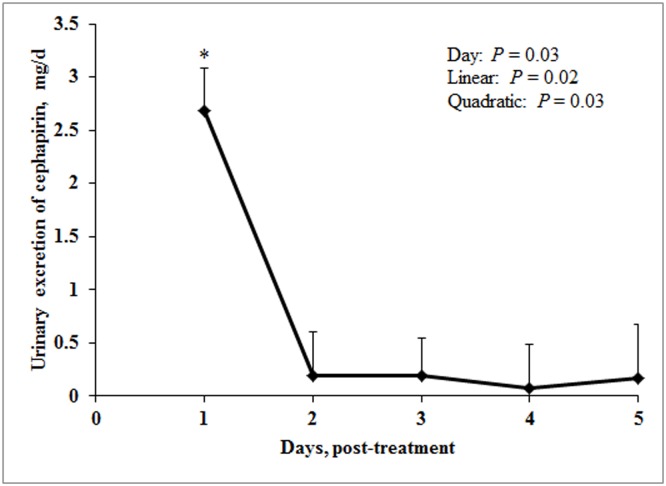
Daily urinary excretion of cephapirin (mg) in dairy cows administered with cephapirin (300 mg/quarter) via intramammary route.Data is represented as least square means with error bars as standard errors. Symbol * indicates that day 1 is significantly (P<0.05) different from all other days.